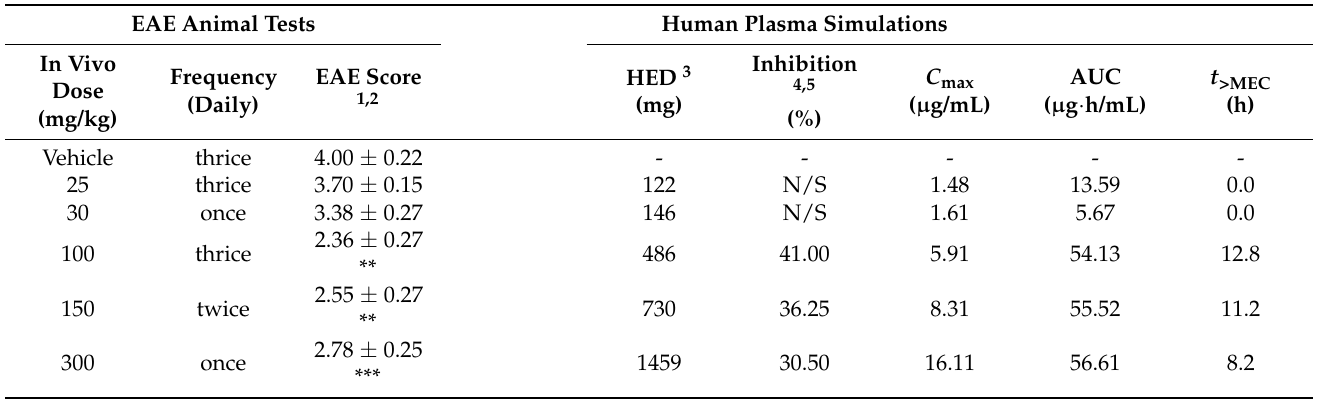
Table 2. Exploring for pharmacokinetics/pharmacodynamics correlation of sobrerol: Human